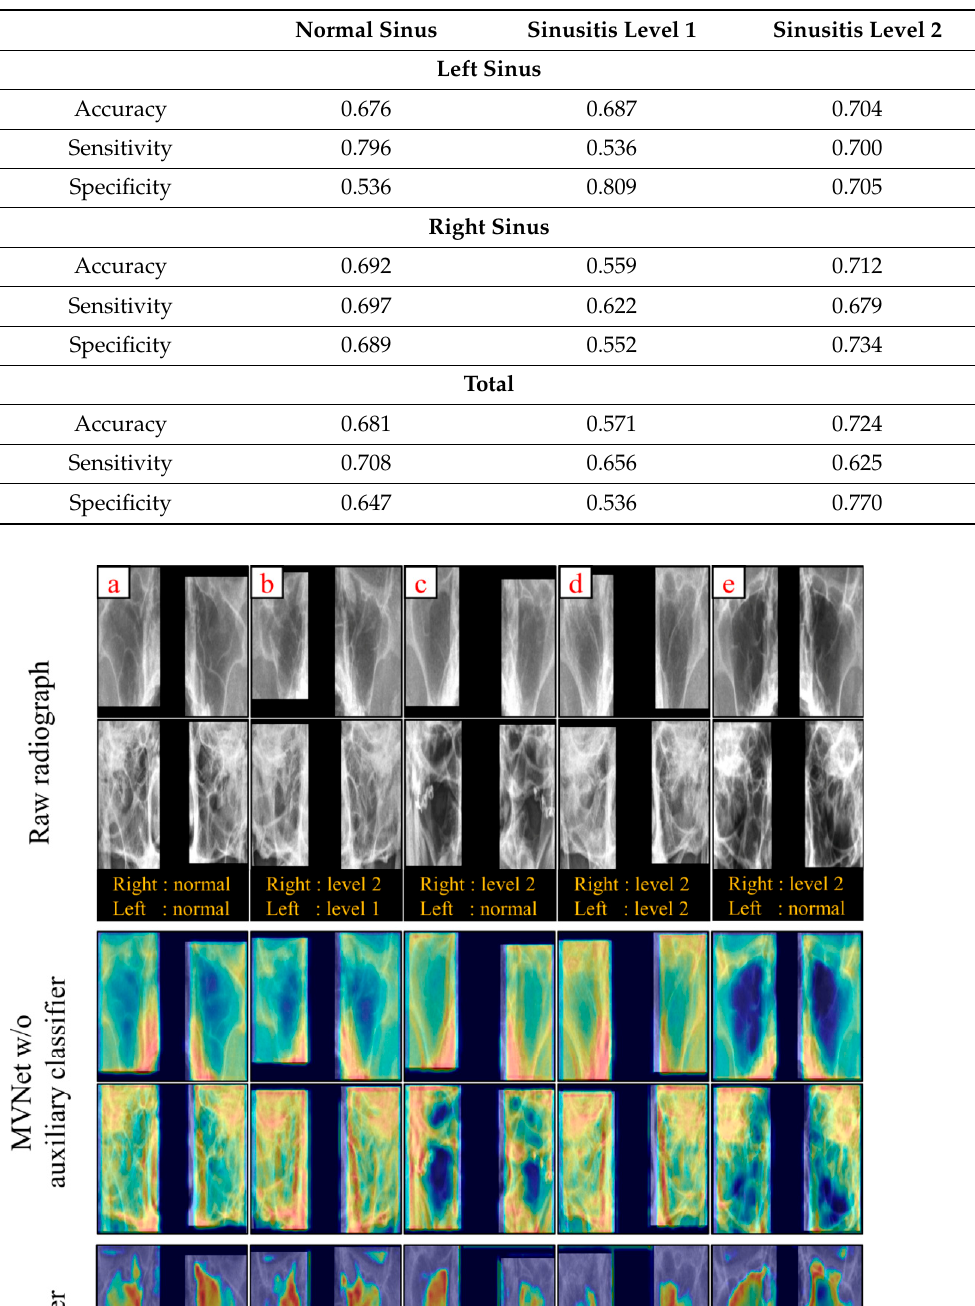
Table 3. The evaluation result of Aux-MVNet.